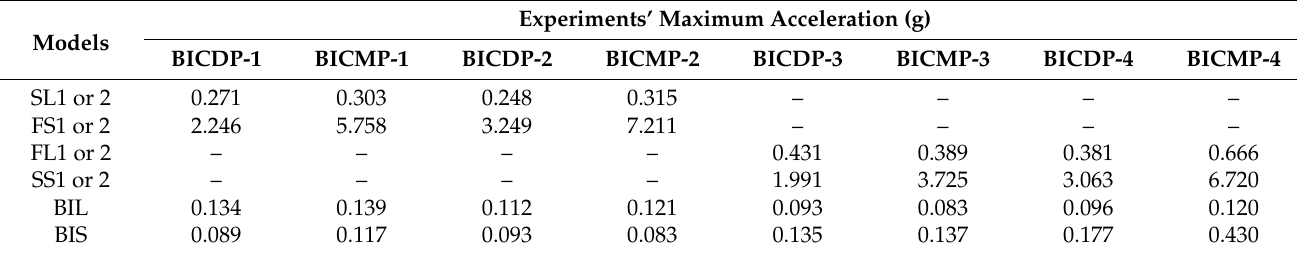
Table 9. Maximum response in a combination of different frequency